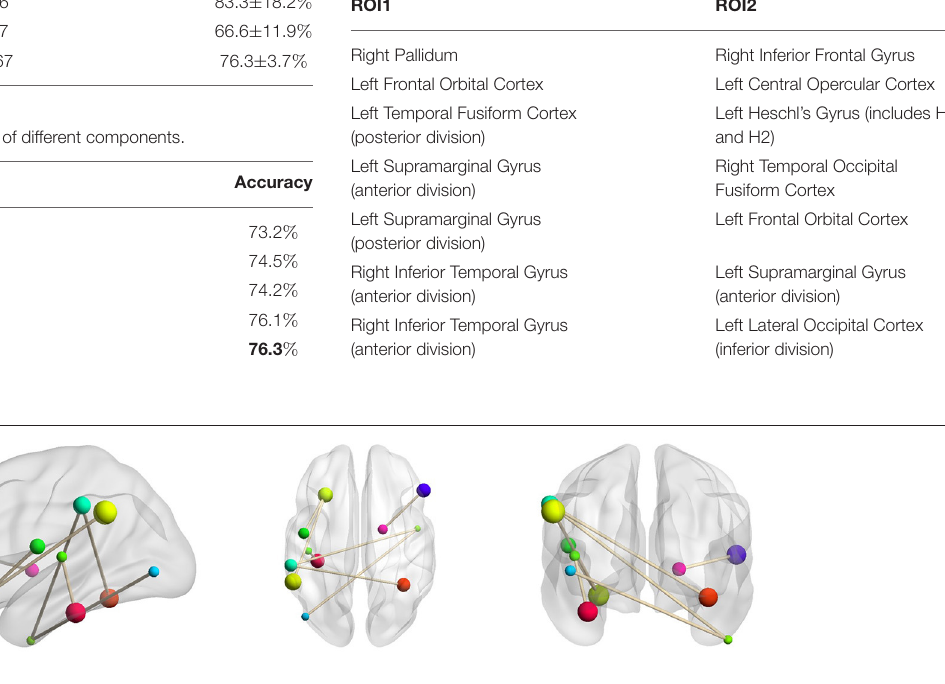
FIGURE 5 | Selected key connectivity features for ASD